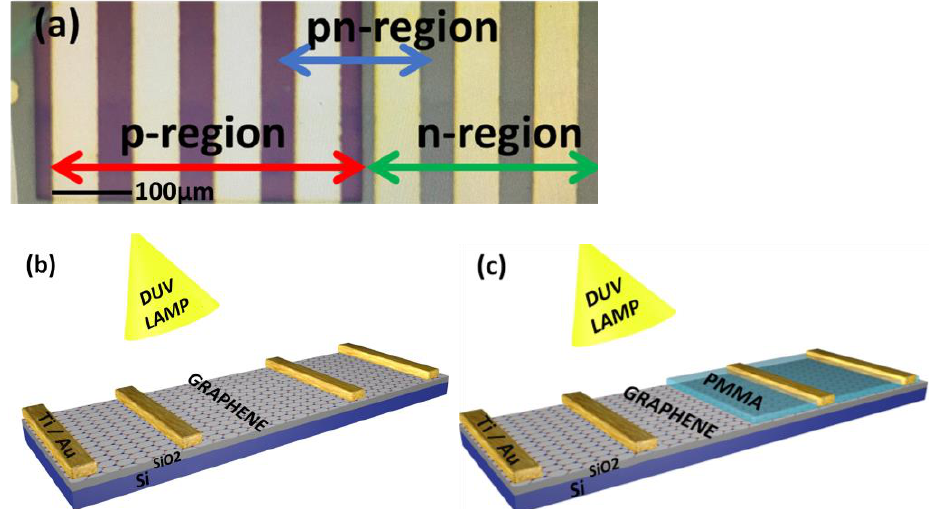
Figure 1. Optical microscope image and schematic figure: ( a ) The optical microscopic image of the fabricated device defining the p, n, and pn-junction regions of the GFET. ( b ) A schematic figure of the fabricated GFET device exposed to DUV irradiation under different environmental conditions. ( c ) A schematic figure of the pn-junction, fabricated on a single layer graphene channel of a GFET device by utilizing the DUV doping effect in air and vacuum and coating graphene partially by double PMMA layers.